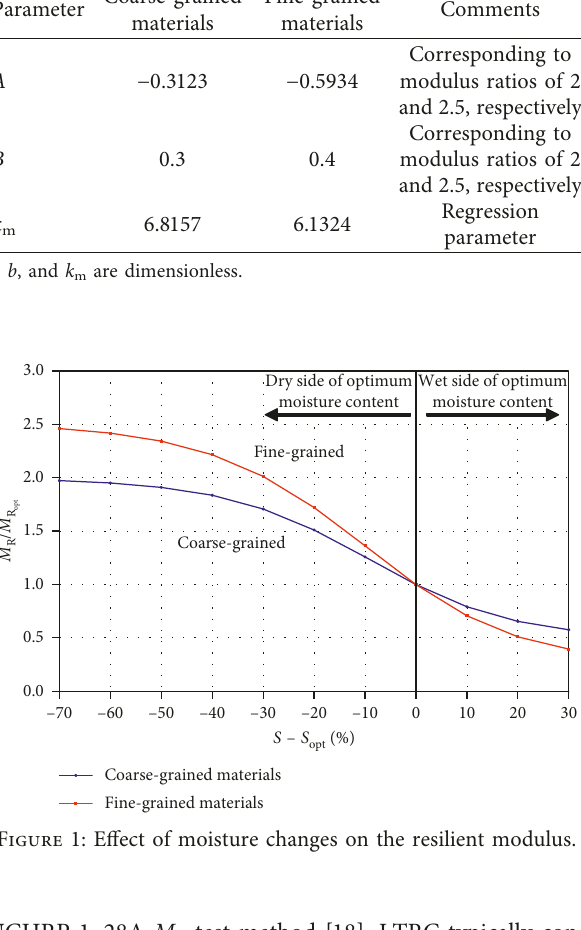
m for coarse-grained and fine-grained